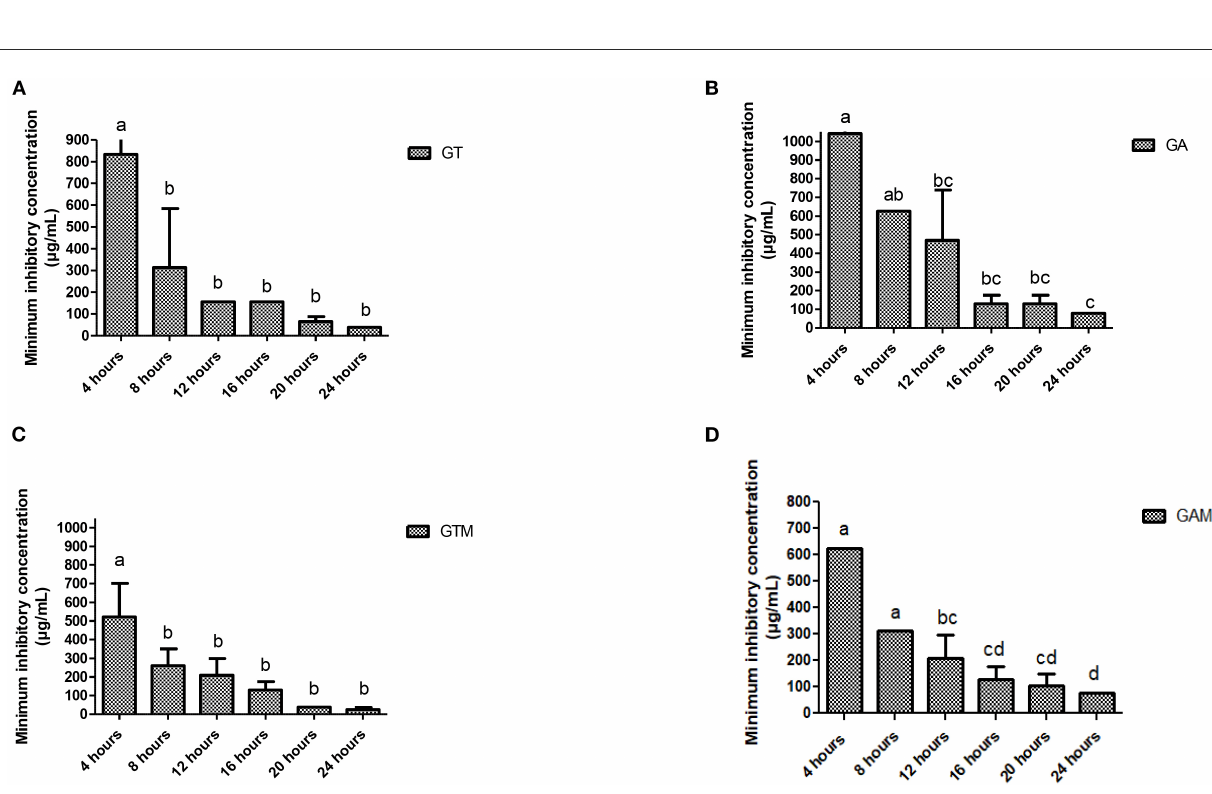
FIGURE4 (A–D) Comparison of minimum inhibitory concentrations ( µ g/mL) among different incubation times for each preparation against S. agalactiae . (A) GT, sodium alginate-stabilized tylosin. (B) GA, sodium alginate-stabilized ampicillin. (C) GTM, sodium alginate-stabilized tylosin and MgO nanoparticles. (D) GAM, sodium alginate-stabilized ampicillin and MgO